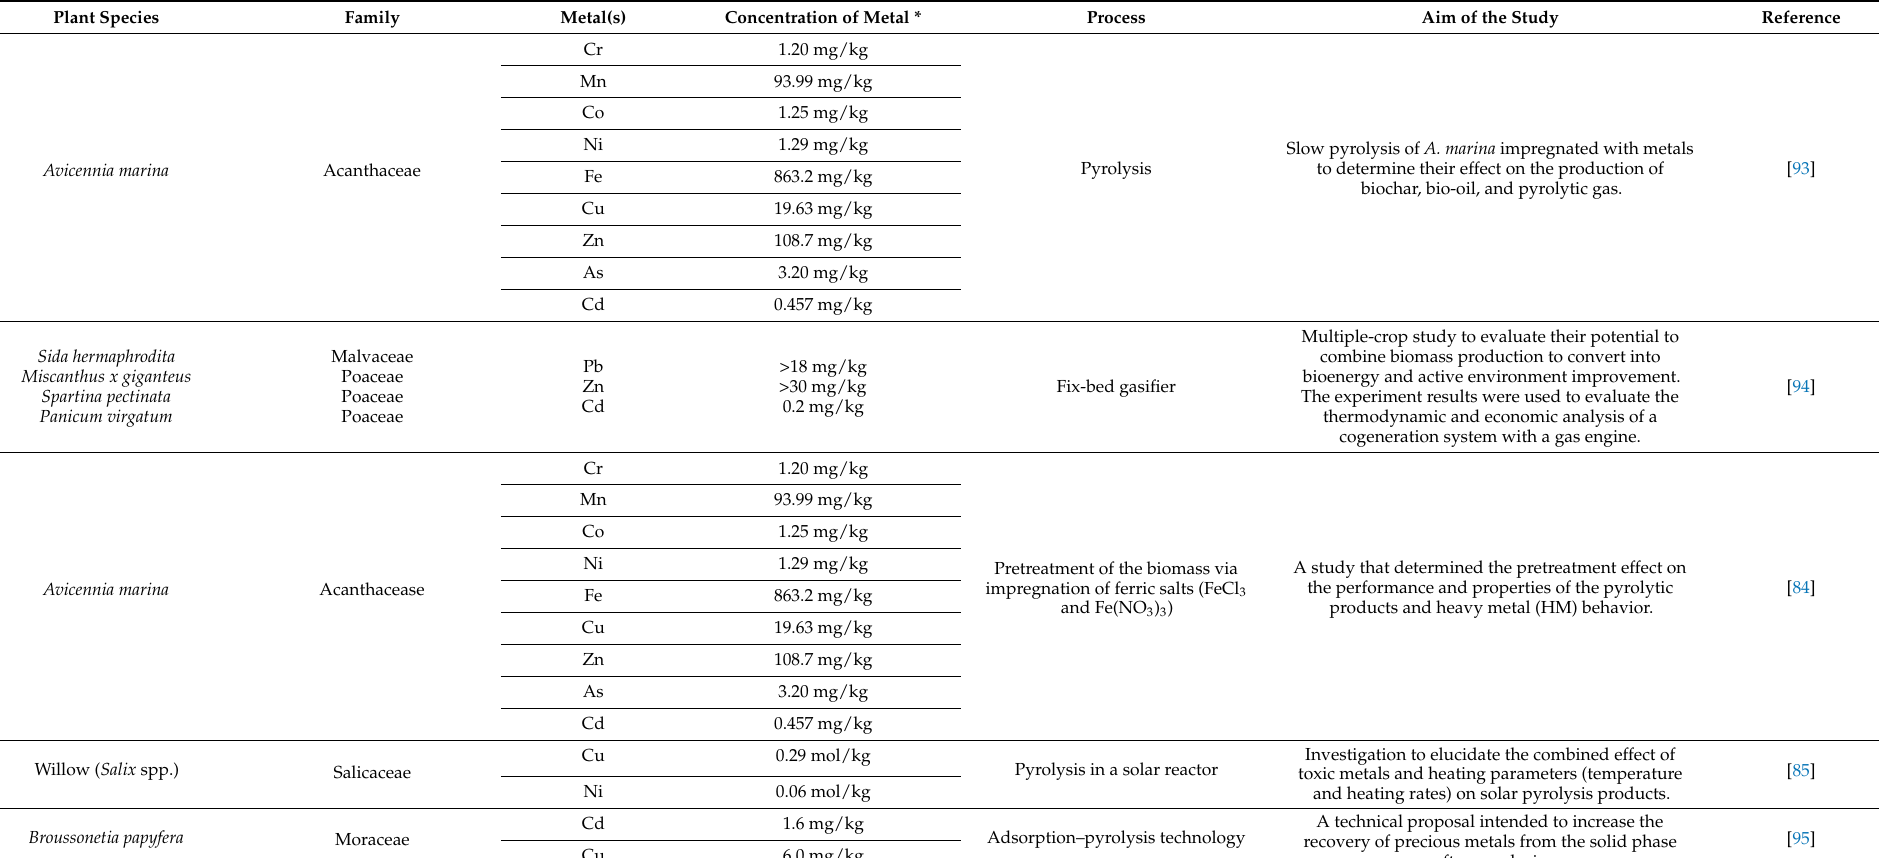
Table 3. Studies related to the use of phytoremediation biomass as feedstock in thermochemical